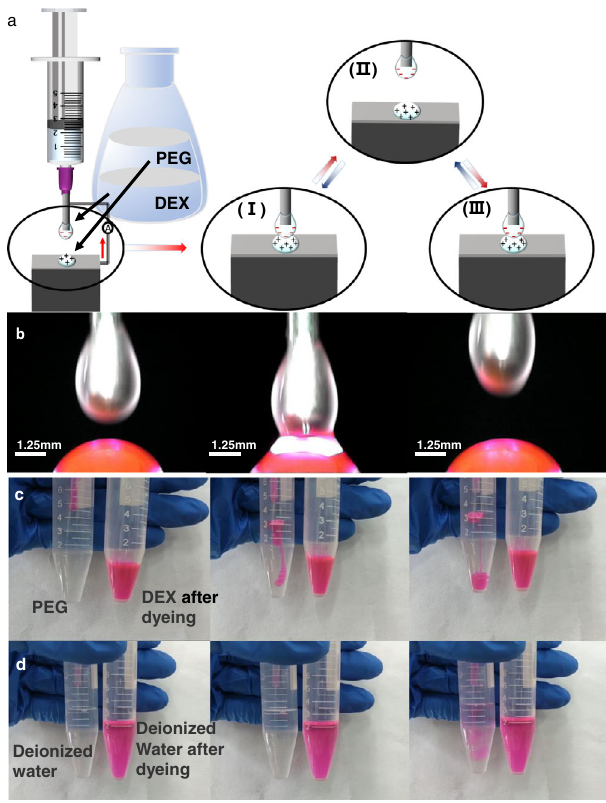
Fig.1|DemonstrationoftheL-LTENGbasedontheaqueoustwo-phasesystem. a Contact-separation working mode of the L-L TENG. b Optical images of DEX dropletanddyedPEGdropletcomingintocontactandseparating. c Imagesofdyed DEXdropletdrippedintoPEGtoformanIAAI. d Opticalimagesofadyeddeionized water droplet dripped into undyed deionized water without the formation of an